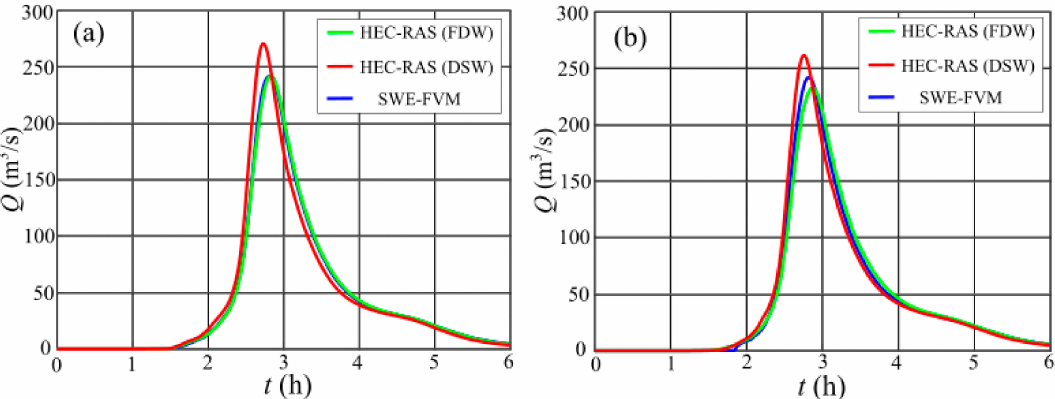
Figure 3. Discharge hydrograph simulated with HEC-RAS and SWE-FVM models for a return period of 200 years: element size 5 m ( a ) and 10 m ( b ).